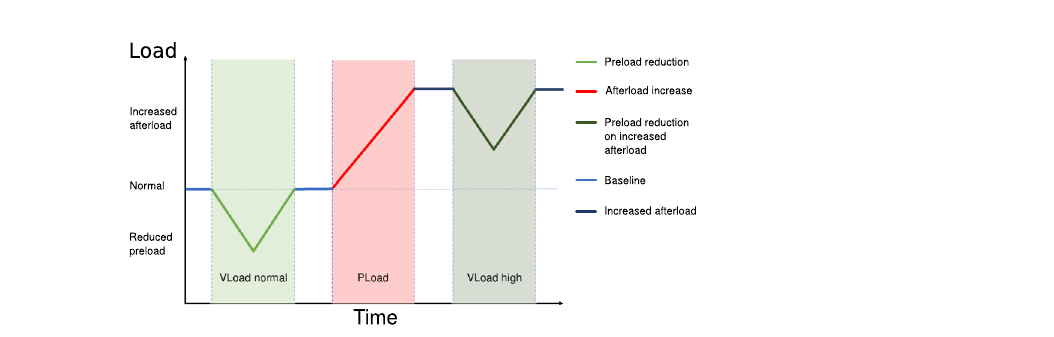
Figure 2. Course of the load interventions with a preload reduction (VLoad normal) followed by an afterload increase (PLoad) and, finally, a preload reduction of an elevated afterload level (VLoad